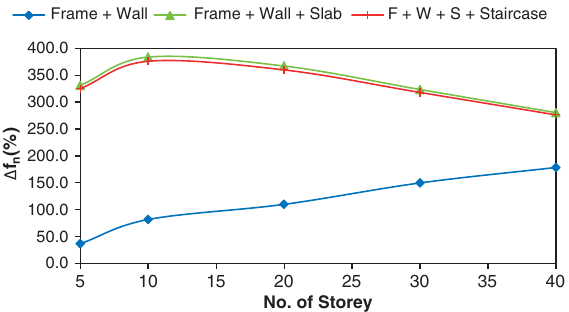
Fig. 14. Increment of natural frequency, Δ f n , considering effect of staircase